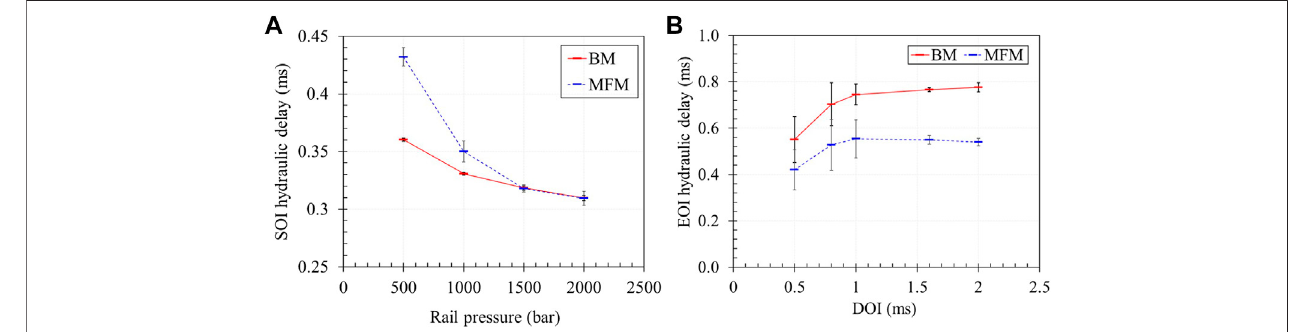
FIGURE 4 | Comparison of the calculated hydraulic delays from BM and MFM; (A) at different injection pressures; (B) at different DOI.